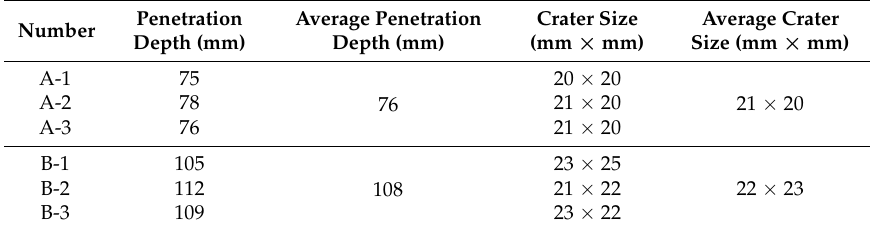
Figure 6. The macroscopic features of the targets penetrated by ( a ) Cu-Ni-Al and ( b ) Ni-Al jet. Table 3. The penetration depth and entrance aperture data of RSCLs.